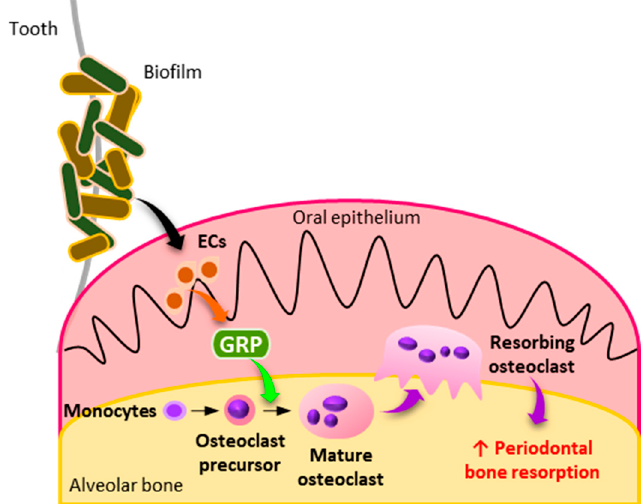
Figure 6. Illustration of this study’s results. Under inflammatory conditions during periodontitis, ECs release GRP which binds to GRPR on BMMs. This leads to the activation of GRPR downstream signaling and, subsequently, promotes osteoclastogenesis, resulting in enhanced periodontal bone resorption.